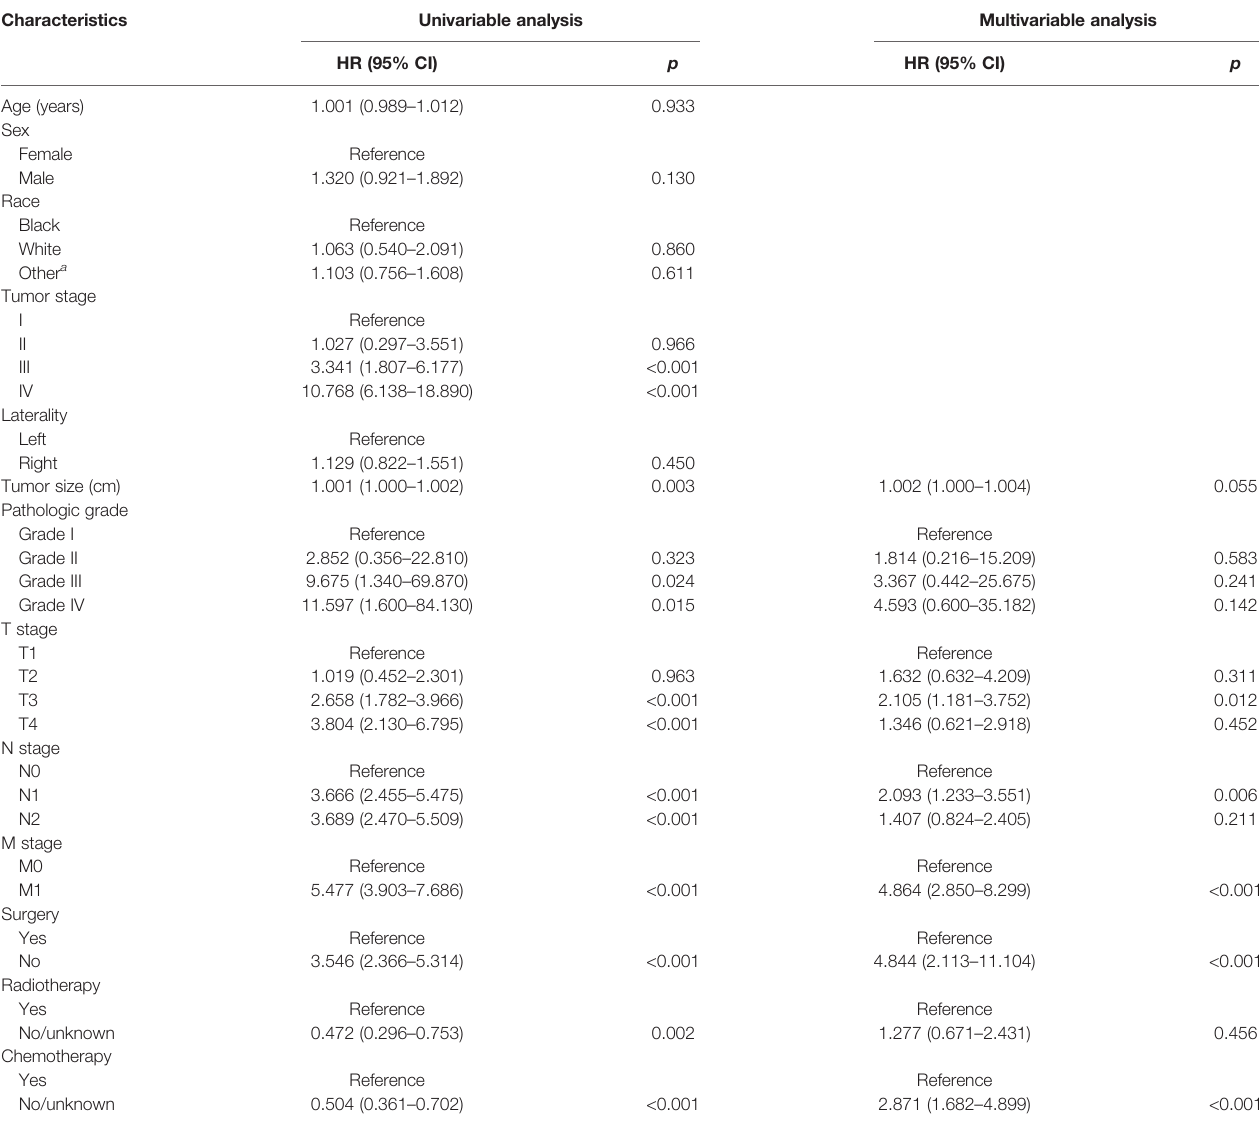
TABLE 2 | Univariate and multivariate Cox regression analysis of the associations between clinicopathological features and CSS in patients with CDCs.